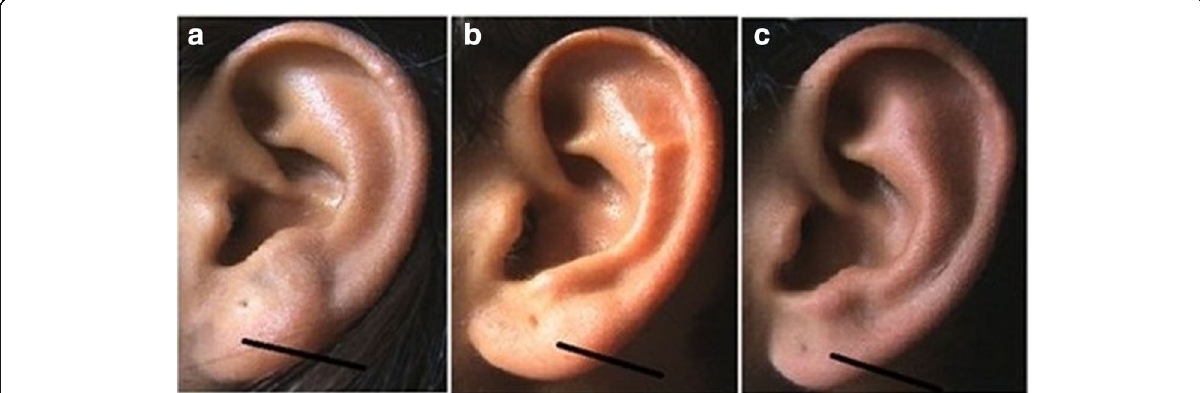
Fig. 6 Photographs showing the thickness of the earlobe. a Thick. b Medium. c